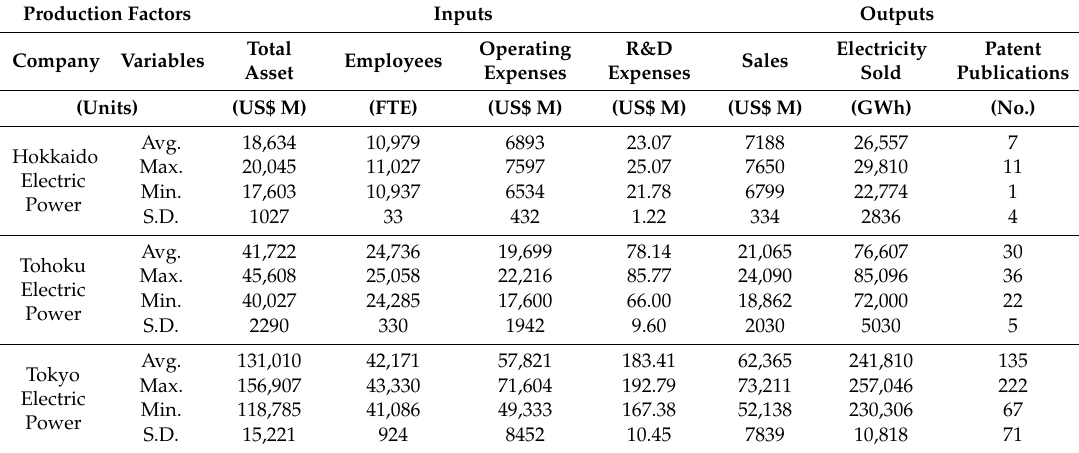
Table 4. Descriptive Statistics of Japanese Power Companies (cid:48)